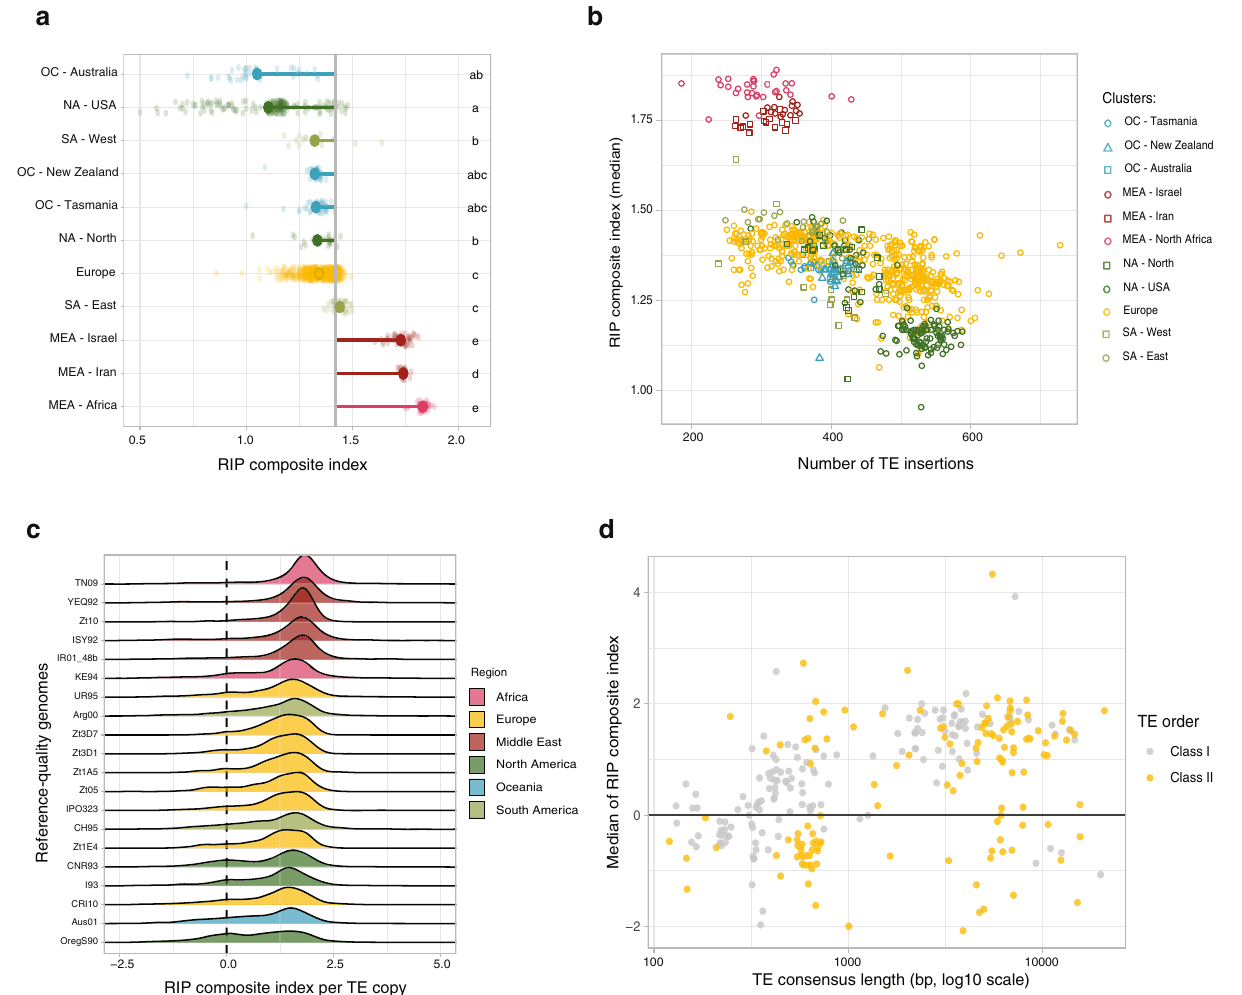
Fig. 4 | Relaxation of genomic defenses against transposable elements. a RIP composite index in the TEs for each isolate (small transparent dot) and as an average per genetic cluster (large opaque dot). Names of the clusters include an abbreviationofcontinentsandamoreprecisegeographicallocation(MEA:Middle East and Africa; NA: North America; SA: South America; OC: Oceania). The grey verticalline represents the overallaverage. b Dotplotrepresenting the numberof